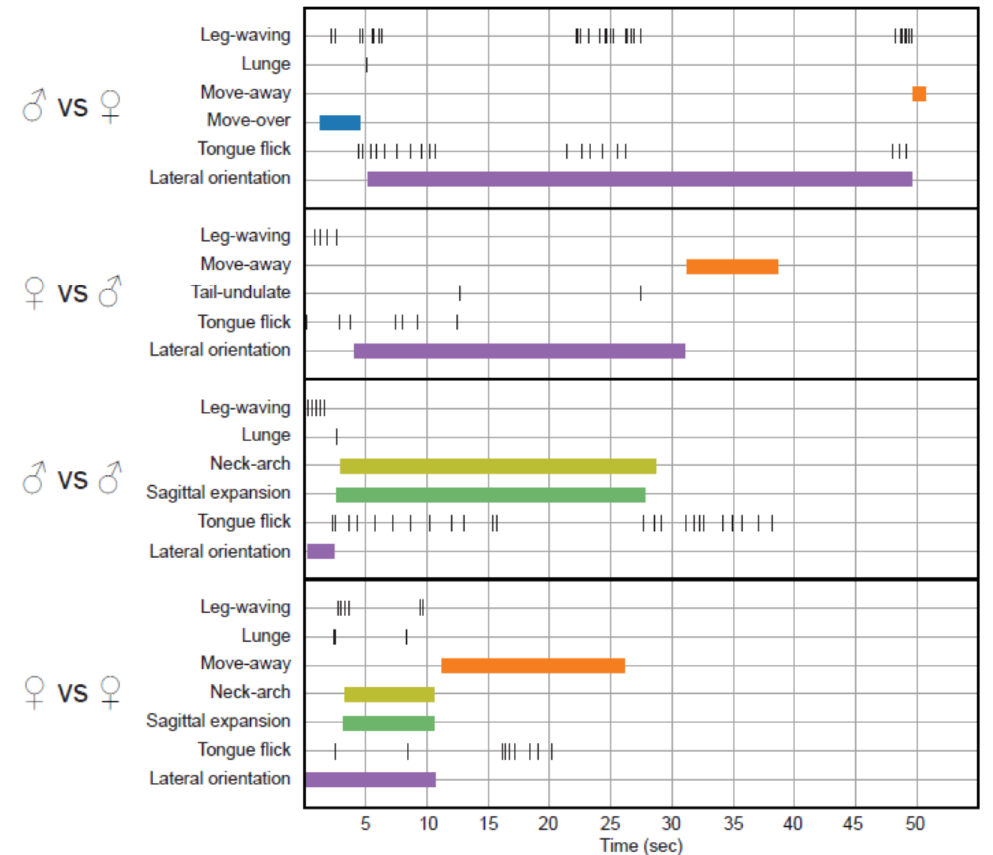
Figure 3. Time budget graphic in four experiments, one per stimulus context. We selected interactions which presented the largest number of performed behaviors.